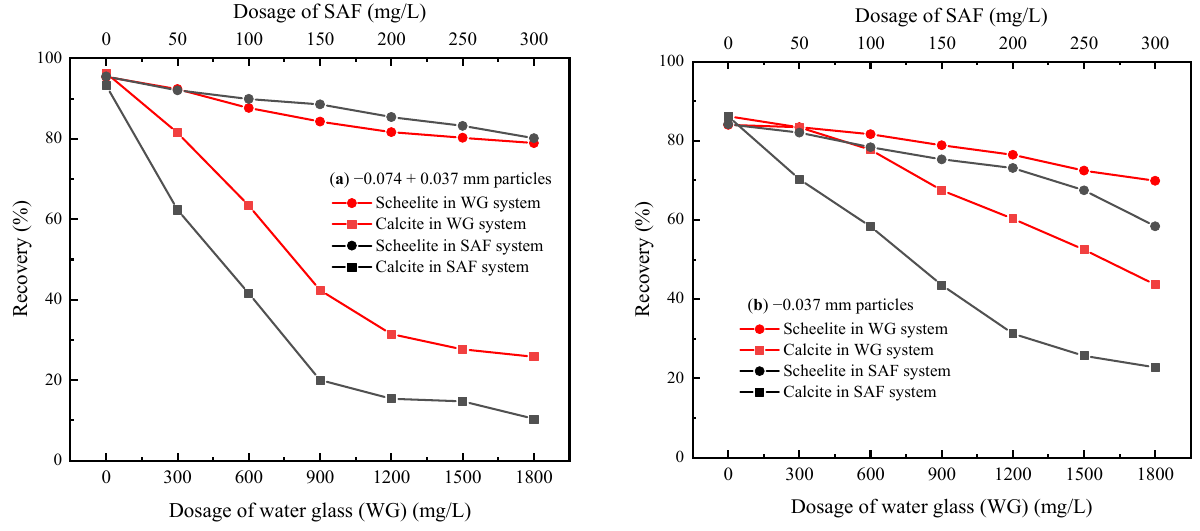
Figure 5. Recoveries of scheelite and calcite as functions of depressant dosage in the presence of 50 mg/L NaOL at pH 9. ( a ) − 0.074 + 0.037 mm particles, ( b ) − 0.037 mm particles.